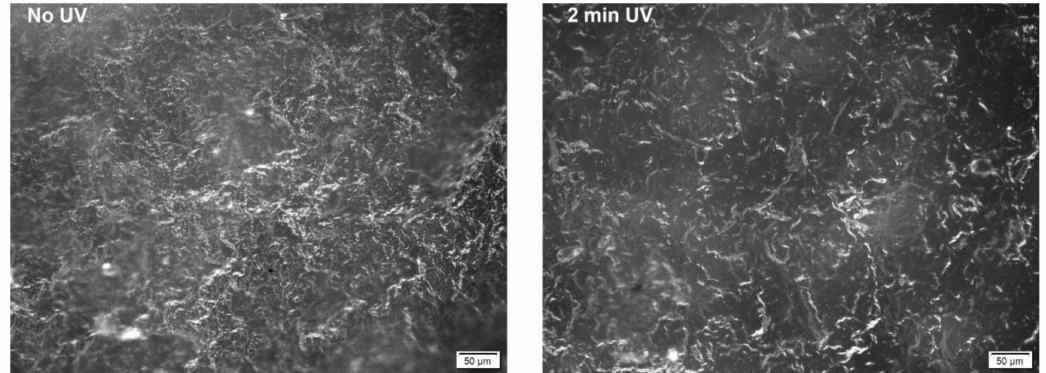
Figure 4. Reflection dark field images of MFC-EC-5%PI uncured (left) and with 2 min of UV exposure per side (right).